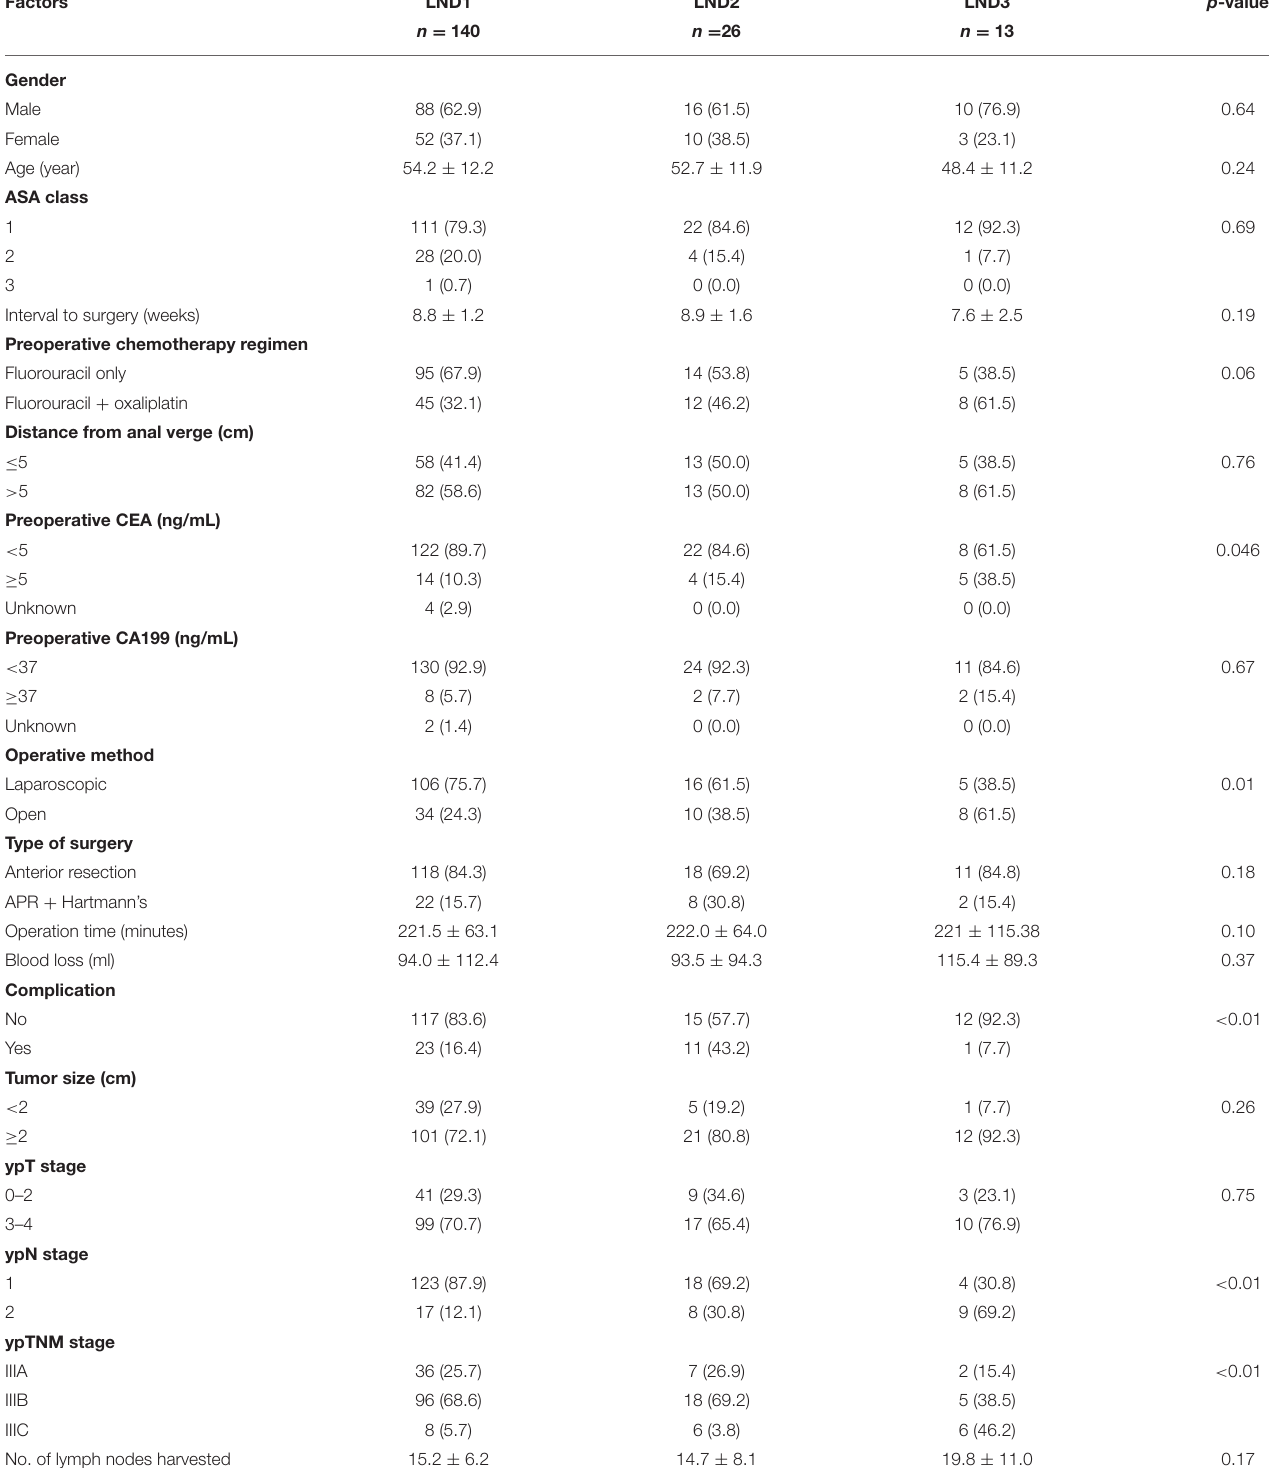
TABLE 1 | Clinicopathological factors according to the distribution of lymph node metastasis (LND).